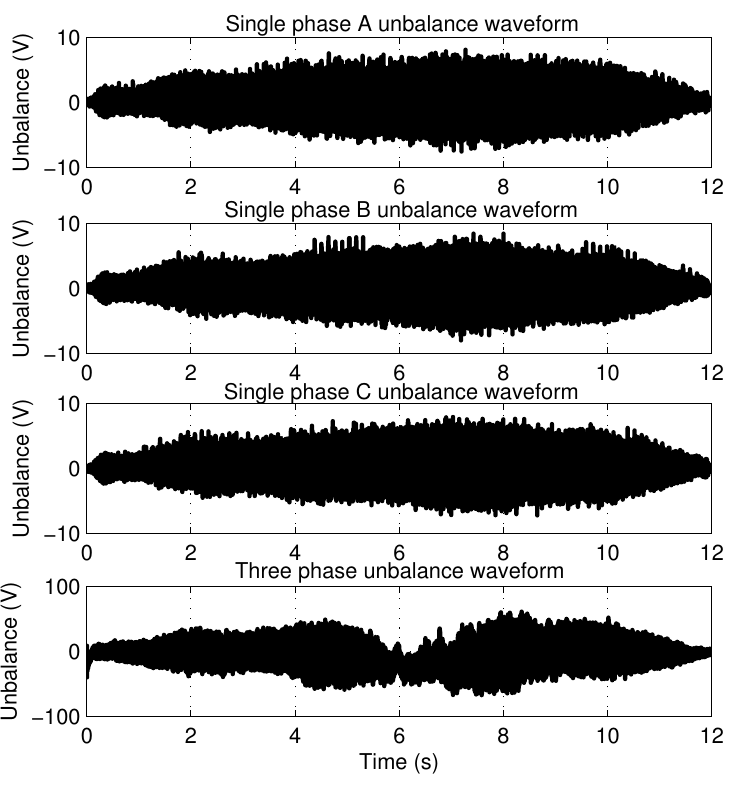
Figure 12. Neutral point voltage during stochastic simulations expressed as the difference between the upper and lower